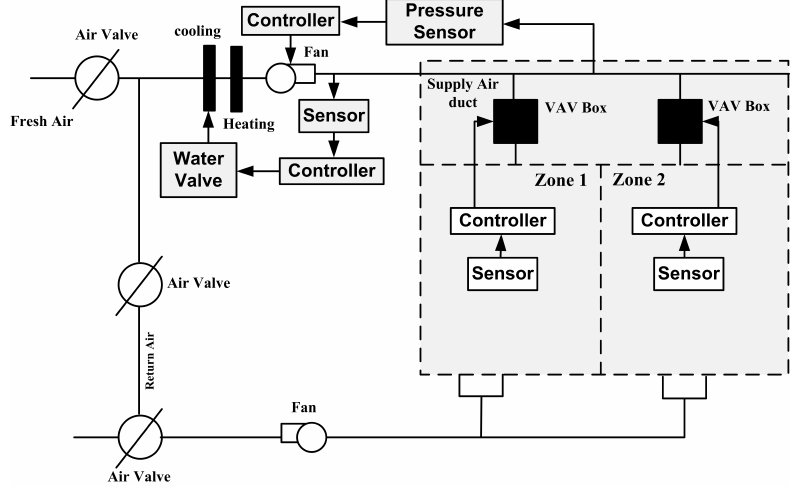
Figure 1. System description of the two-zone variable air volume (VAV) system. Table 1. The three control loops of the variable air volume (VAV) air conditioning